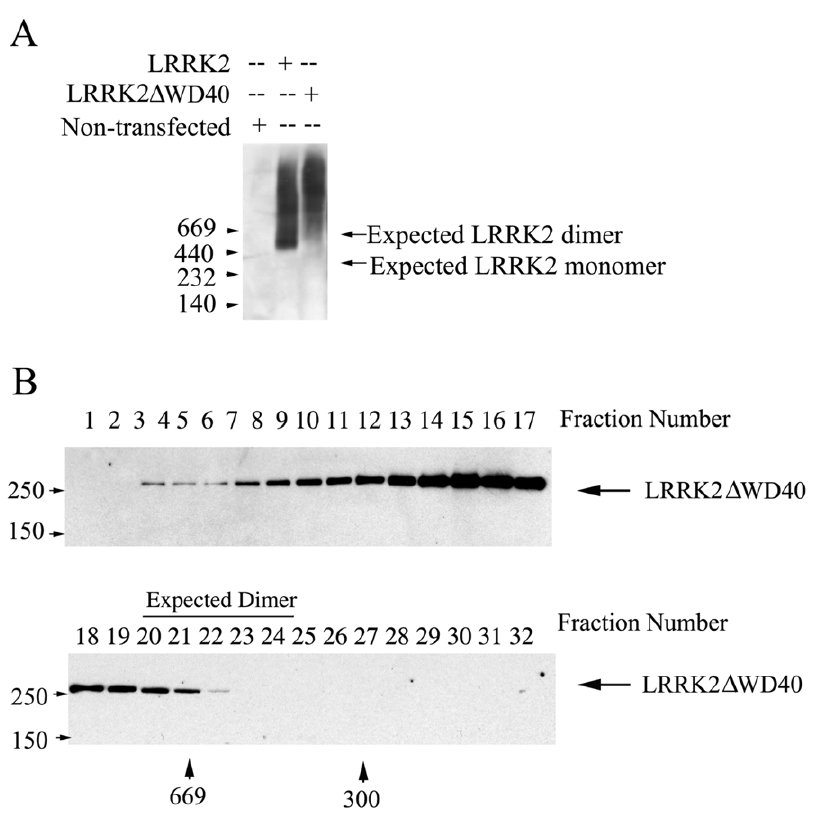
Figure 4. The WD40 domain is necessary for the formation of the dimeric LRRK2 a -complex. (A) Native gel electrophoresis demonstrates absence of the LRRK2 dimer for D WD40-LRRK2, and an increase in the high molecular weight LRRK2 immunoreactivity (B) Size-exclusion gel filtration chromatography of D WD40-LRRK2 similarly demonstrates a decrease in the a -complex and increase in b -complex.